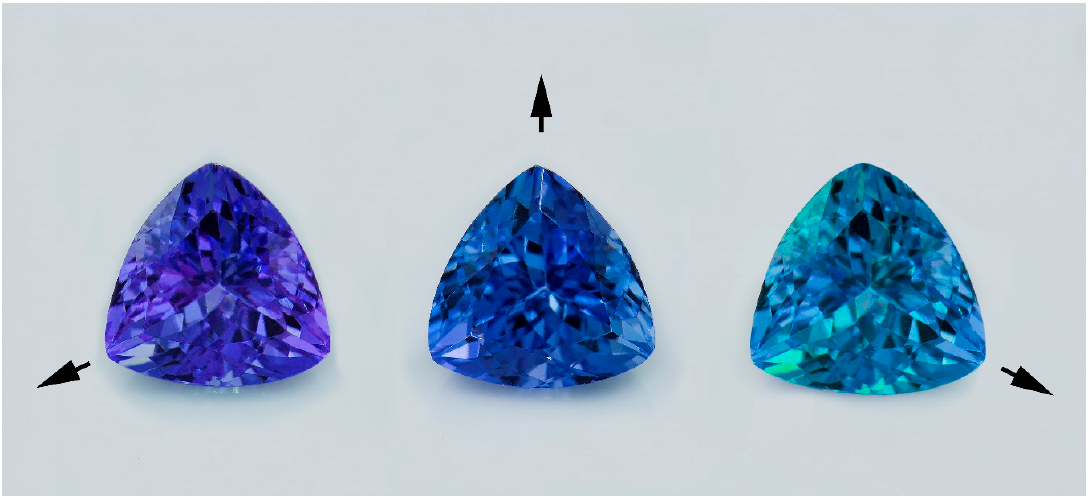
Figure 1. Trichroism of a natural tanzanite rotated in three directions showing violet, blue, and green pleochroic colors (photo by T. Sripoonjan, GIT).